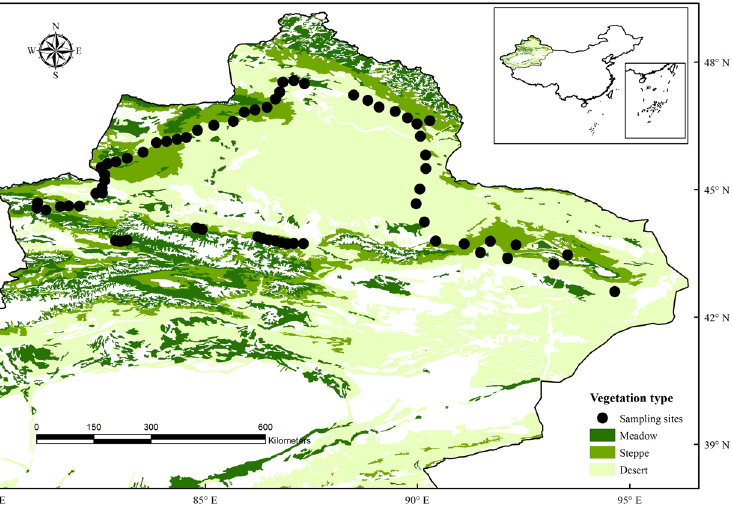
Figure 1. Locations of the study sites in typical dryland of Northwest China. Our sampling scheme was designed to explore the geographic patterns of plant species in a typical dryland ecosystem, which spans dry-subhumid, semi-arid and arid ecosystems, as demonstrated in the legend. The dataset was provided by the Data Center for Resources and Environmental Sciences, Chinese Academy of Sciences (RESDC) (http://www.resdc.cn), and the maps were created using ArcGIS 10